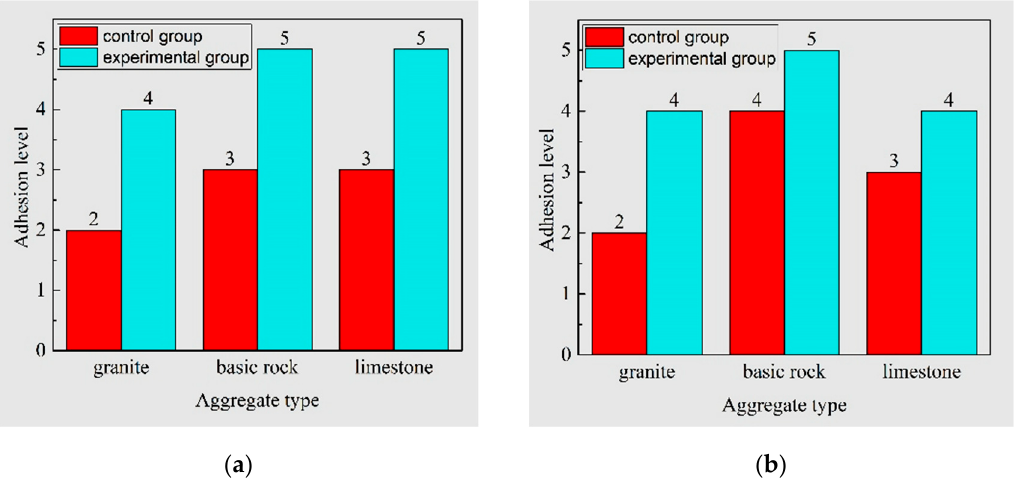
Figure 4. Asphalt-aggregate adhesion level based on stripping test: ( a ) #90 asphalt and ( b ) #110 asphalt (samples without treated were marked as control group, while the ones soaked with plant ash lixivium were marked as experimental group).